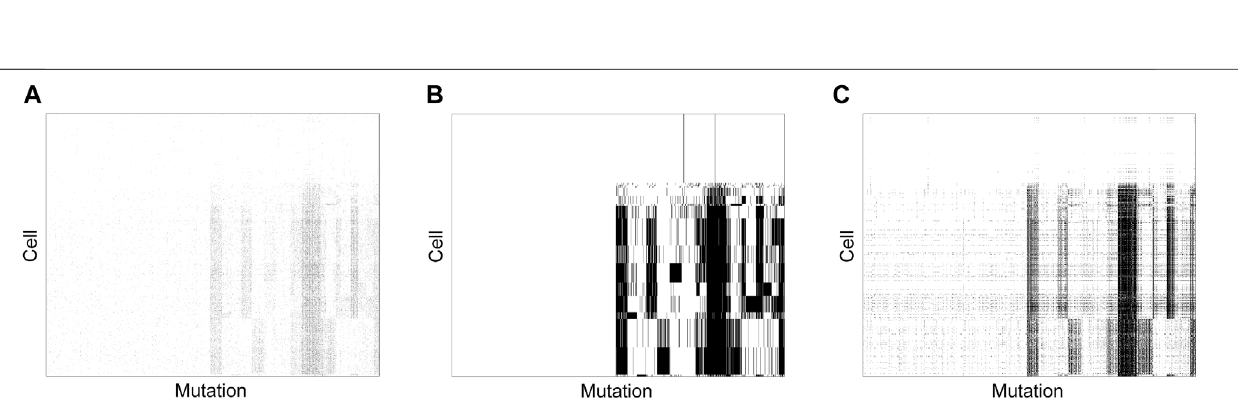
FIGURE 10 | Subclones inferred from IDH-mutant gliomas dataset. SCClone identi fi es 18 subclones and estimates the error rates as α = 0.64% and β = 82.38%. (A) Theobserved926×1,392genotypematrix. (B) TherecoveredgenotypematrixandinferredsubclonesbySCClone. (C) Therecoveredgenotypematrixandinferred subclones by